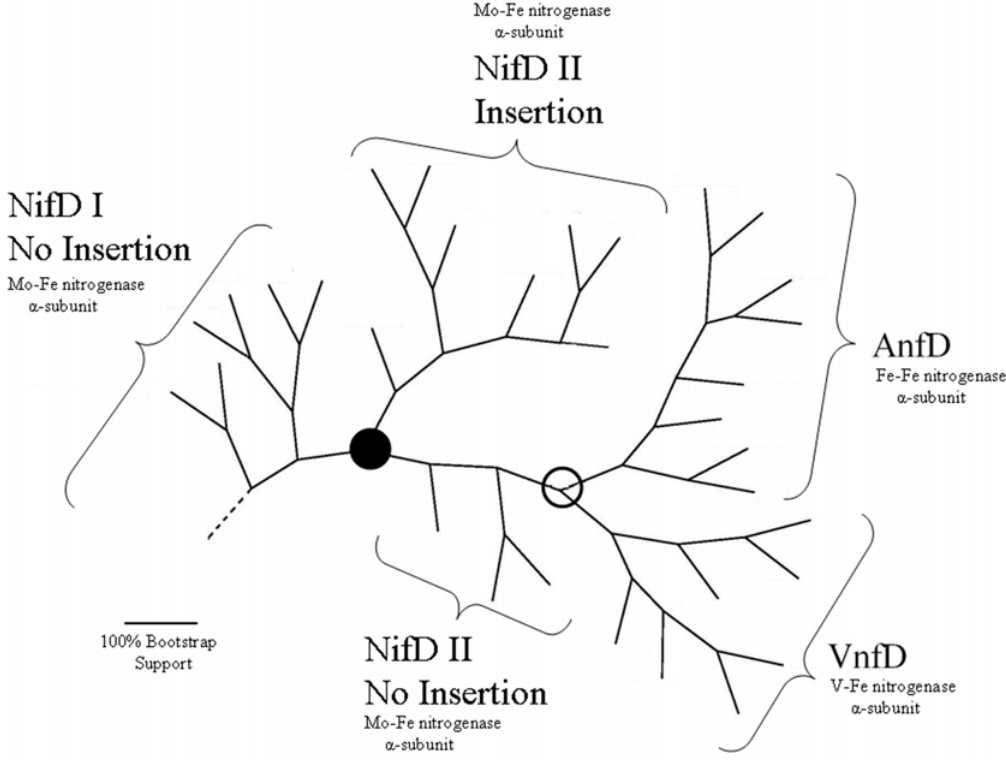
Figure 3. Summary of nitrogenase phylogeny. Adaptation of Figure 2 summarizing major nitrogenase sub-classes. Nitrogenase types are indicated under each sub-class. The open circle indicates the location of the putative ancestral gene. The filled circle indicates the point in the tree beyond which all the sequences are Group I NifDs.